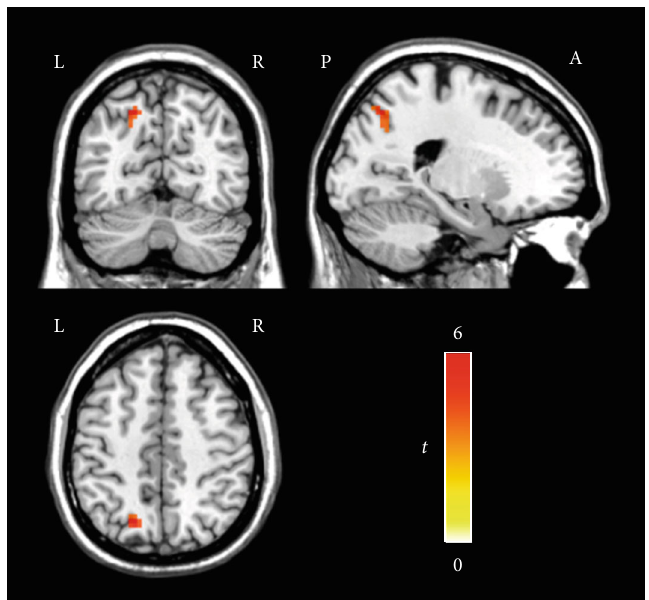
Figure 2: Regions showing increased FC in the DAN in tinnitus patients (voxelwise P < 0 : 001 , FWE-corrected clusterwise P < 0 : 05 ). The tinnitus patients showed increased connectivity in the left superior parietal gyrus in the DAN compared to the healthy controls. The color bar indicates the t value of independent two-sample t -tests between the groups. Acronyms: DAN: dorsal attention network; FC: functional connectivity; FWE: familywise error; L: left; R: right: A: anterior; P: posterior.